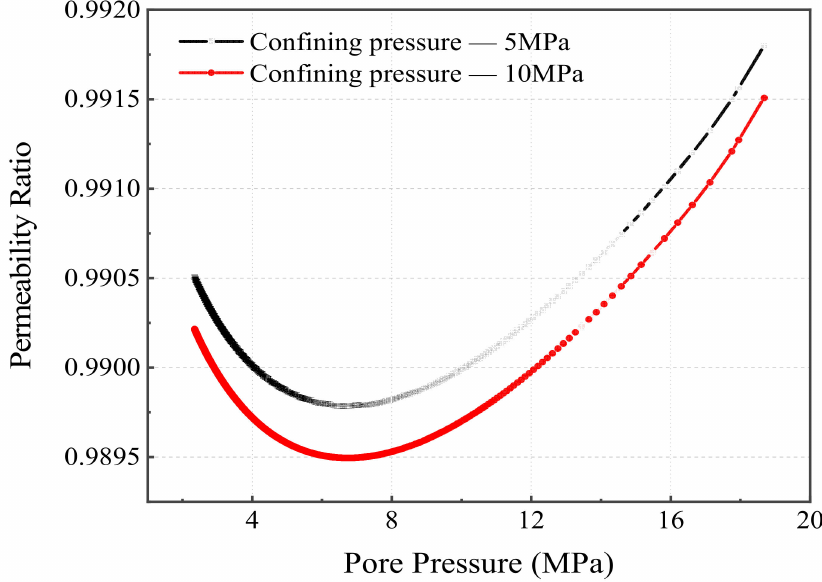
Figure 7. Permeability change curve under different confining pressures considering corrosion and sorption-induced